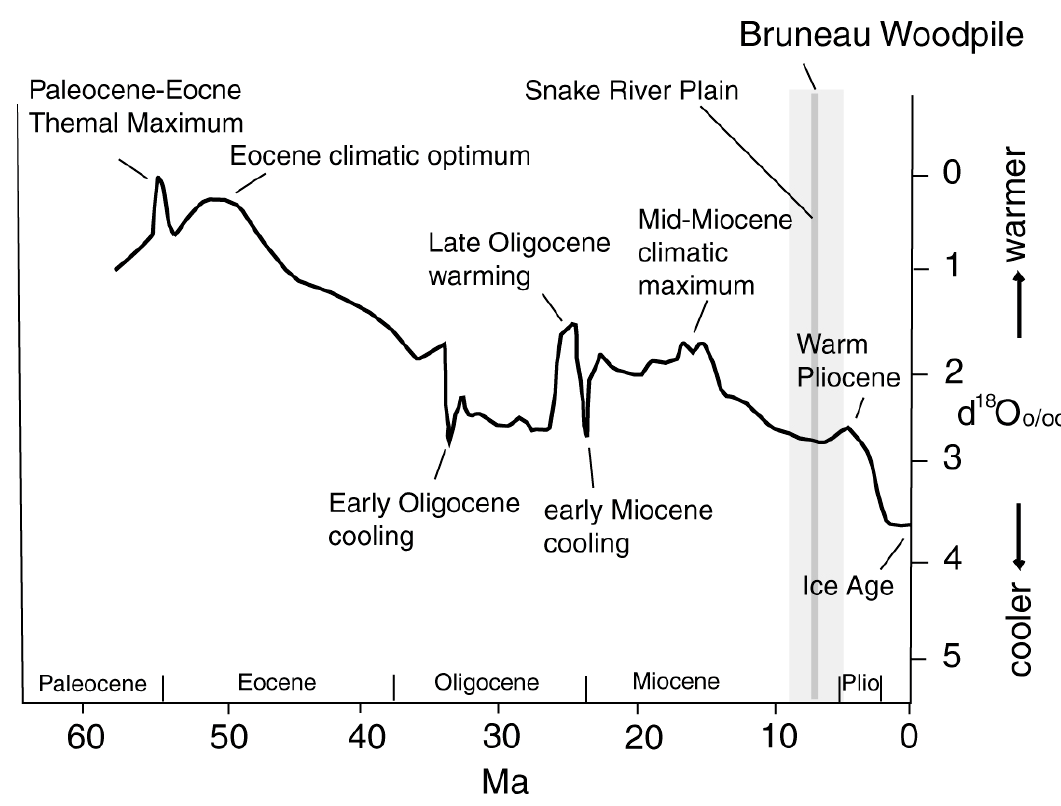
Figure 20. Cenozoic average global temperatures based on oxygen isotope values in marine sediments. Adapted from [80].